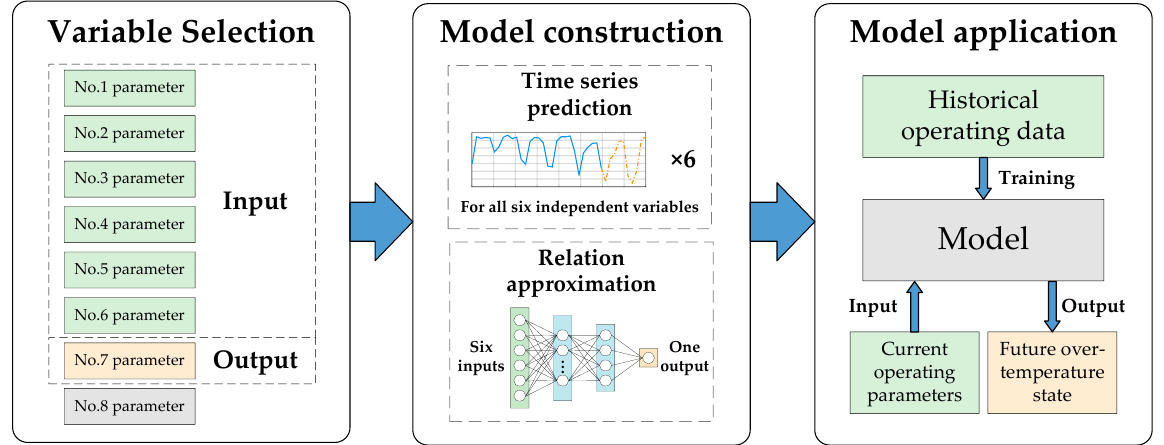
Figure 1. Flowchart of the overall scheme.